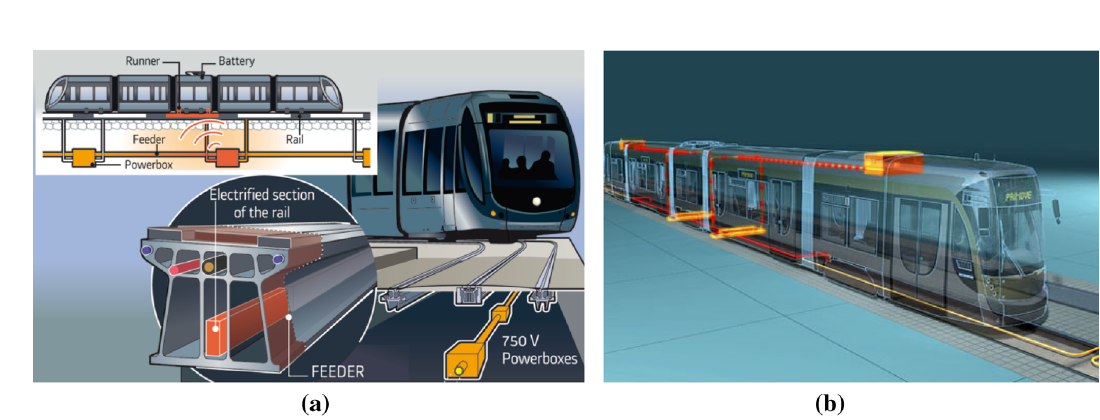
Fig. 1 Catenary-free systems: ( a ) APS Alstom ( source : www.alstom.com); ( b ) Primove Bombardier—wireless ( source :